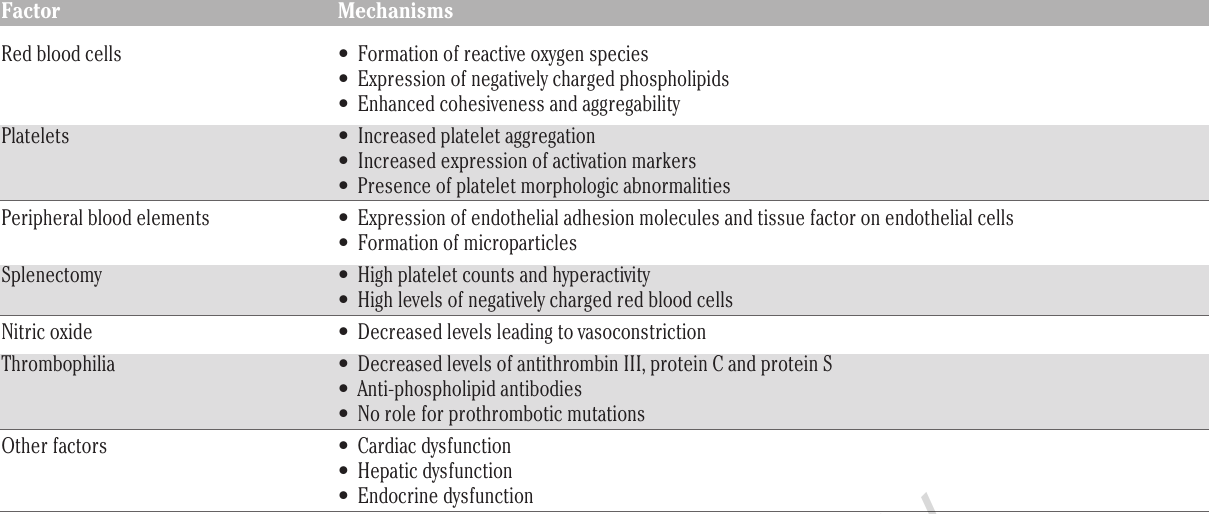
Table 1. Factors contributing to hypercoagulability in thalassemia intermedia. 1 Factor Mechanisms